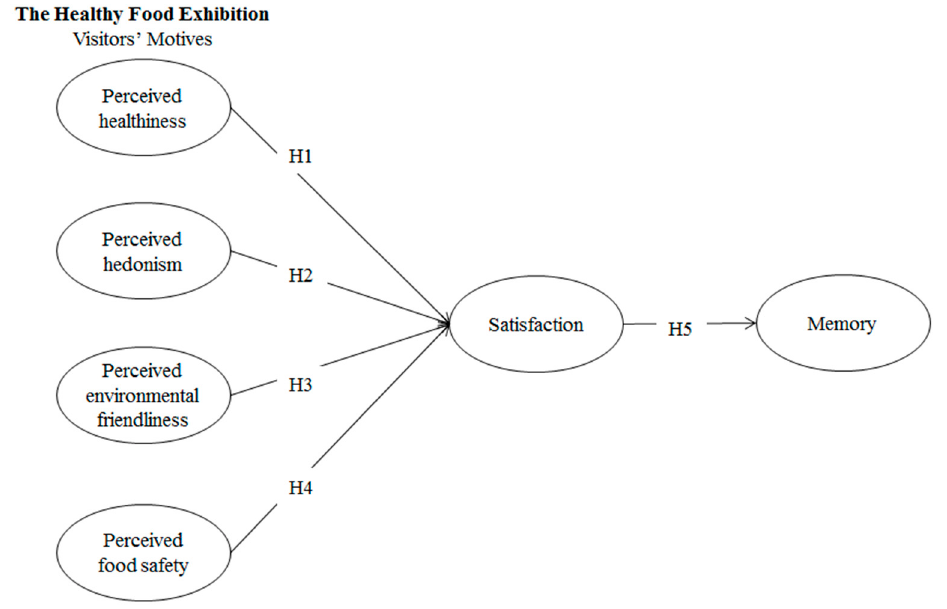
Figure 1. The research model.